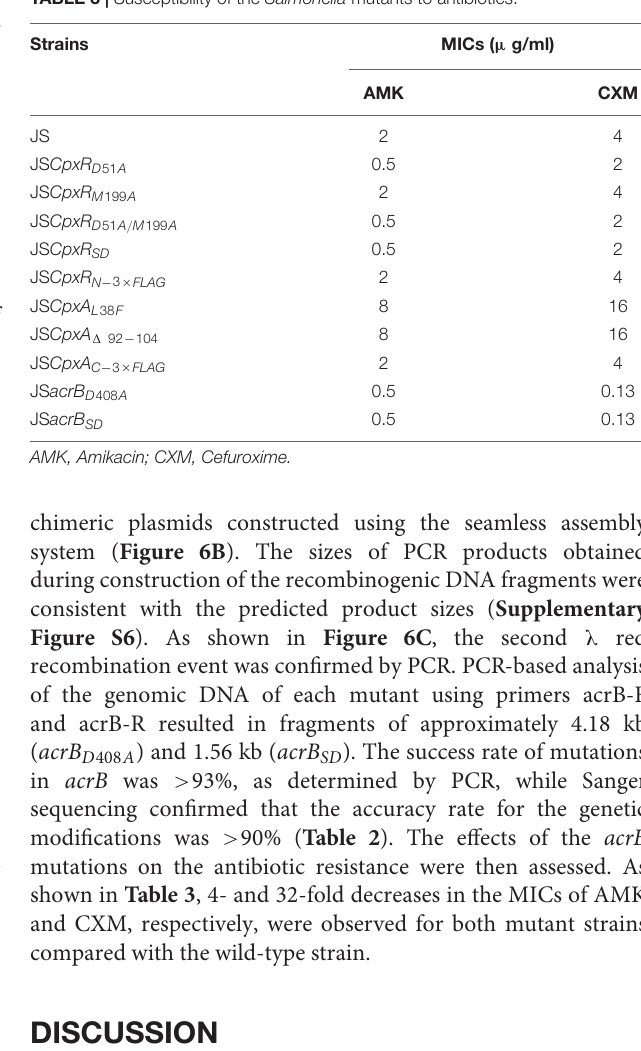
TABLE 3 | Susceptibility of the Salmonella mutants to